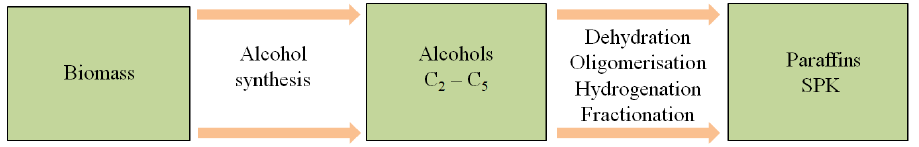
Figure 1. Diagram of the ATJ-SPK process [26].